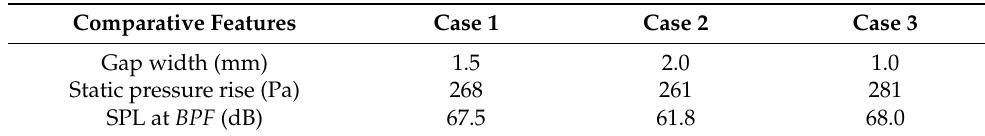
Table 3. Aerodynamic and acoustic performance.